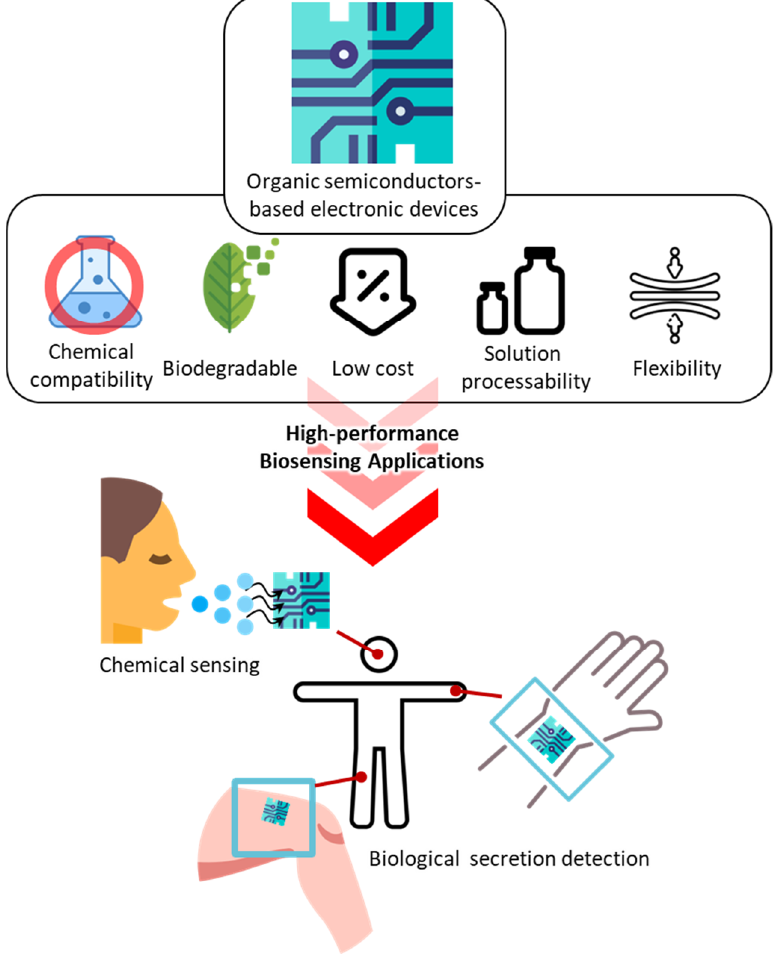
Figure 1. Schematic diagram of the use of organic semiconductors in biomedical applications.